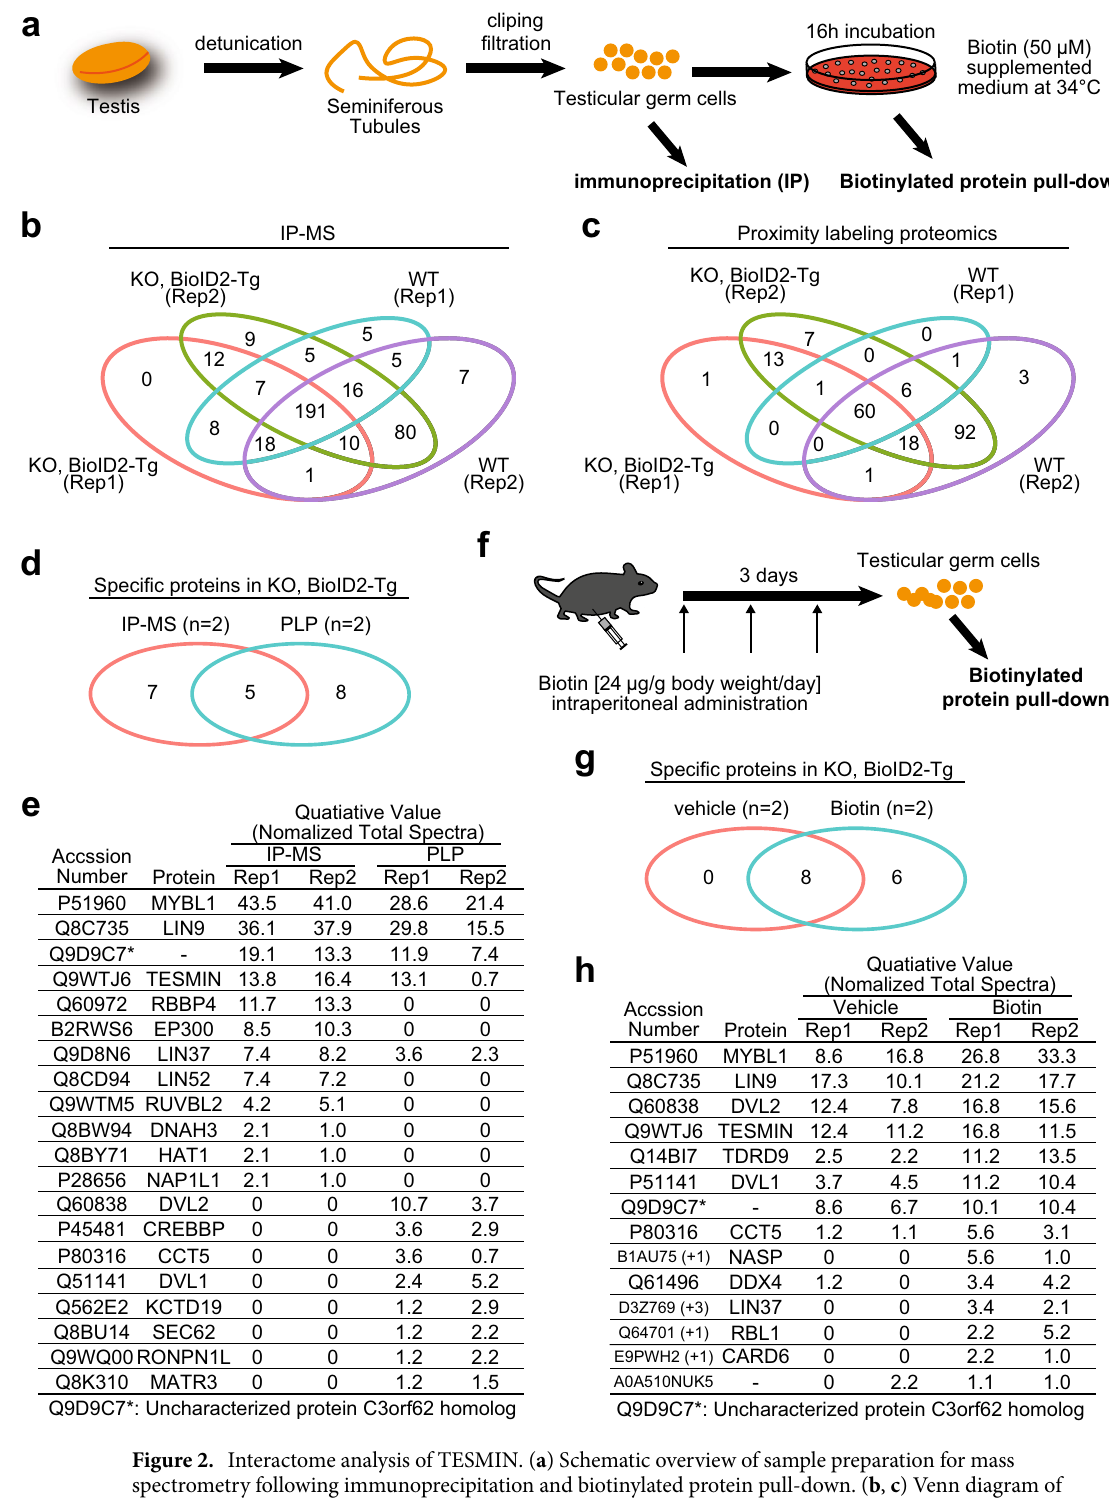
Figure 2. Interactome analysis of TESMIN. ( a ) Schematic overview of sample preparation for mass spectrometry following immunoprecipitation and biotinylated protein pull-down. ( b , c ) Venn diagram of IP-Mass ( b ) and proximity labeling proteomics ( c ) analysis. Two mice were used for each experimental group. ( d ) Venn diagram of proteins that were reproducibly captured in IP-MS ( b ) and proximity labeling proteomics ( c ) using KO, BioID2-Tg mice. Proteins detected at least once in the wild type are excluded (described as specific). ( e ) The list of specific proteins in d and quantitative values (normalized total spectra). The whole data is available in Dataset S1. ( f ) Schematic overview of intraperitoneal administration of biotin. ( g ) Venn diagram of proteins that were reproducibly captured in proximity labeling proteomics using vehicle- and biotin-injected KO, BioID2-Tg mice. Proteins detected at least once in the wild type are excluded (described as specific). ( h ) The list of specific proteins in g and quantitative values (normalized total spectra). The whole data is available in Dataset